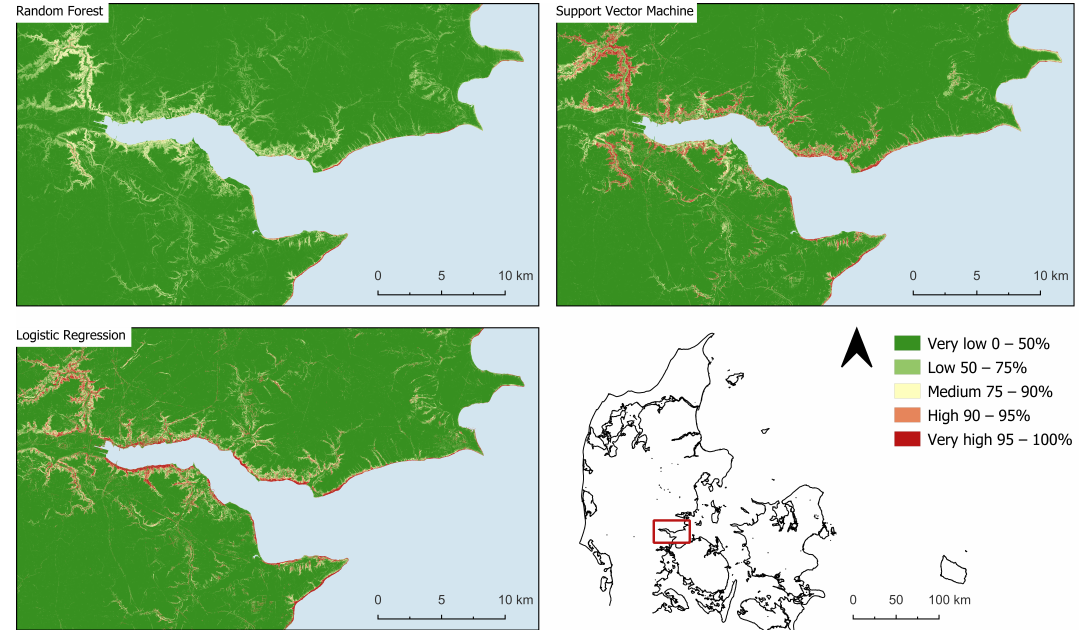
Figure 11. Landslide susceptibility map with Predictor Set II—with climate variables.